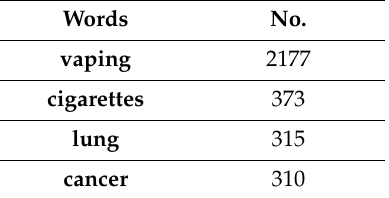
Table 2. Most frequently occurring words in Group 1.